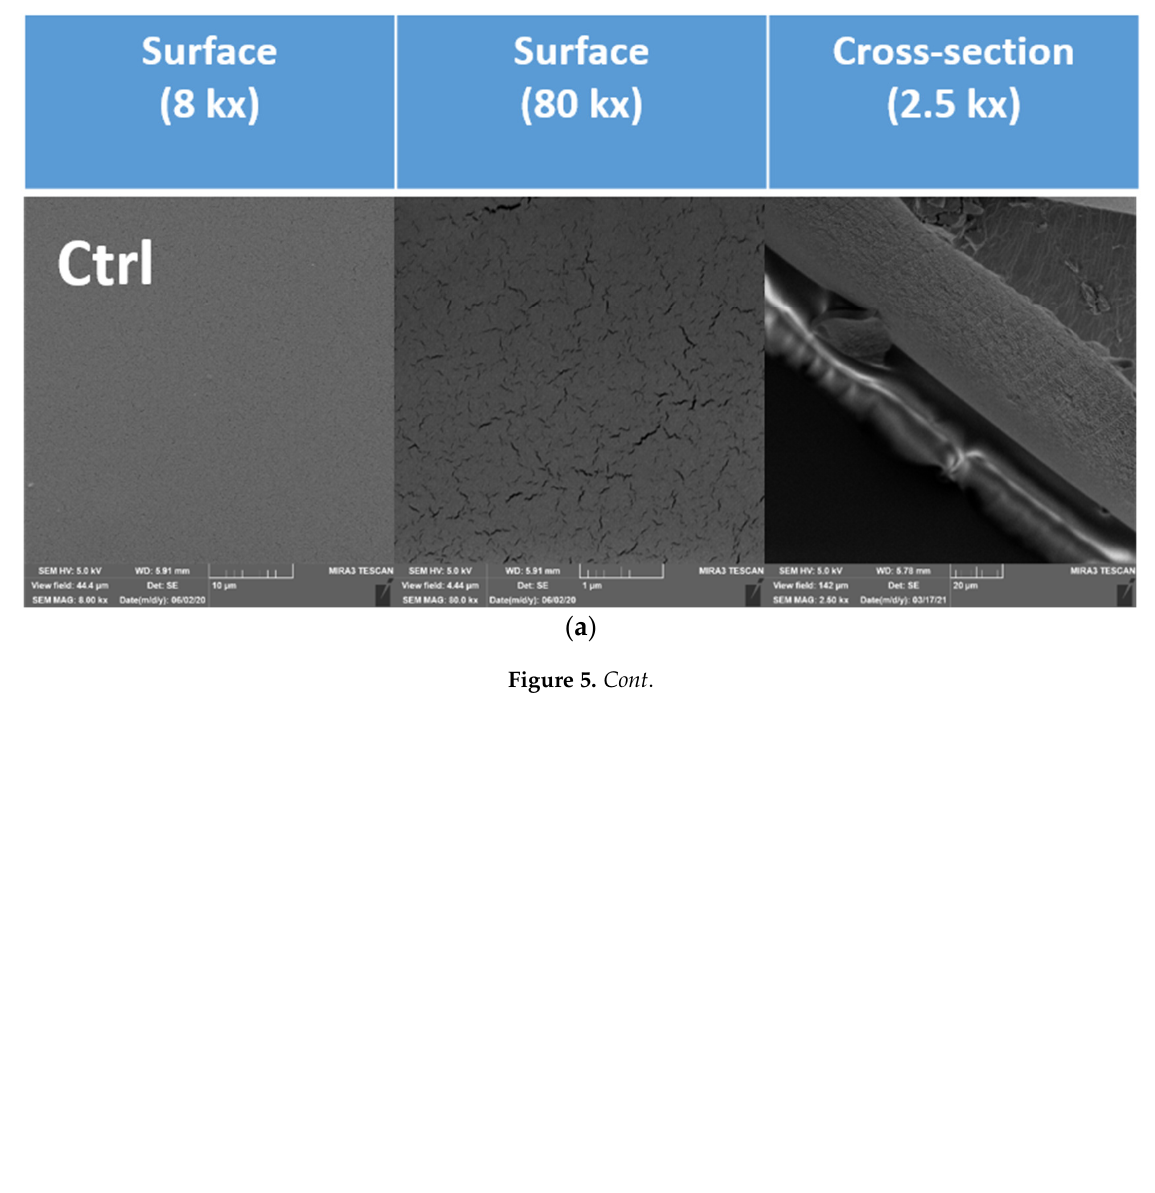
Figure 6 documents the average size of the cracks in the surface of the formed gel. Figure 7 documents the distance between the cracks.